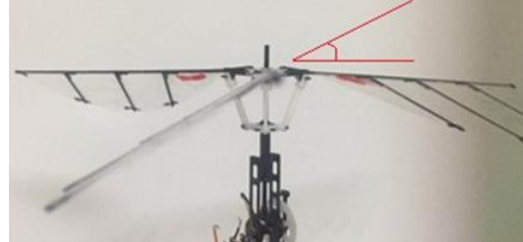
Figure 4. The rigid wing of the FWR without torsion.